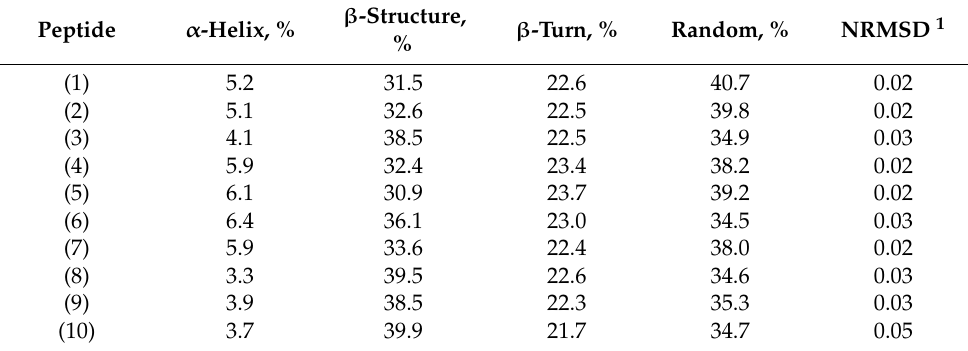
Table 2. Secondary structure of peptides (1)–(10) according to CD spectrum analysis.